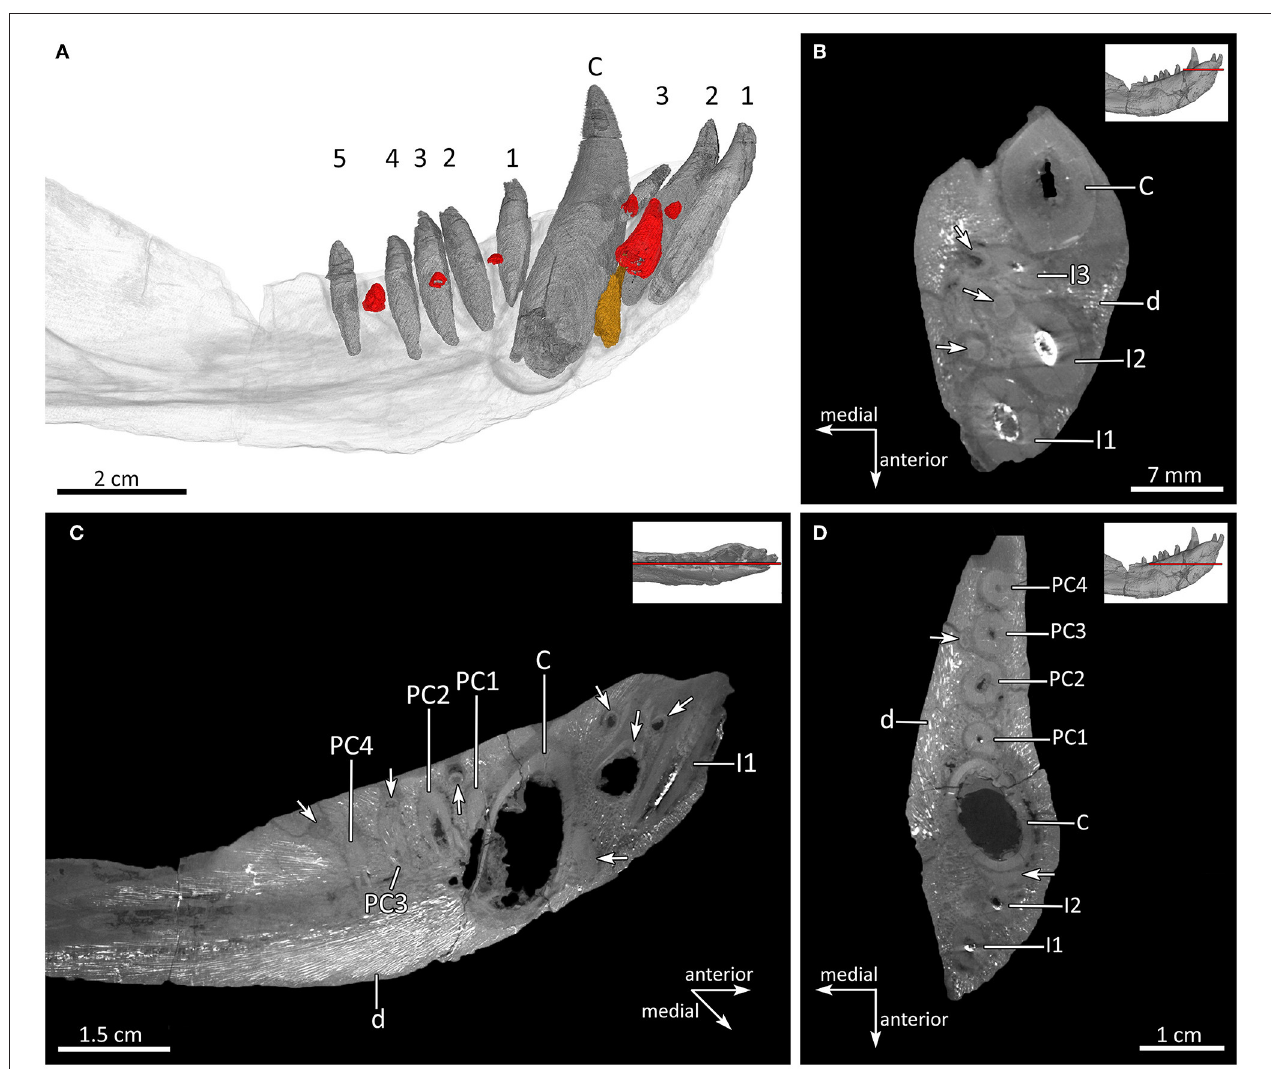
FIGURE 14 | Dentition and tooth replacement in the left mandible of MB.R.995. (A) Three-dimensional rendering of the left lower tooth row in medial view. (B,D) Virtual horizontal CT sections through the left mandible. (C) Sagittal CT section through the left mandible to show the positions of the replacement teeth as seen in (A) . Replacement incisors and postcanines in red; old remnant root of the canine in brown. Arabic numerals indicate the teeth positions. Arrows mark the positions of the replacement teeth and the remnant root of the old canine. C, lower canine; I, lower incisor; d, dentary; PC, lower